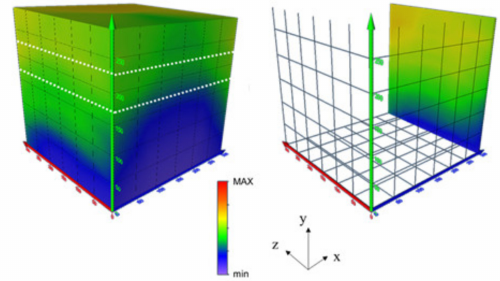
Figure 11. 3D SIBIE result at intact part.